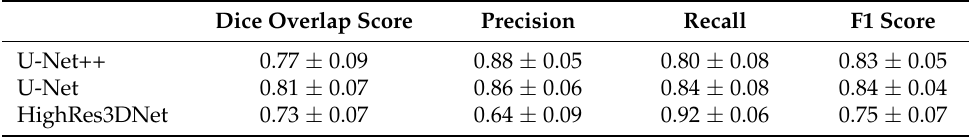
Figure 5. Comparison of the WMH reference and the predicted segmentation from each model (U-Net++, U-Net, and HighRes3DNet). Table 4. Average dice overlap score of WMH, along with precision, recall, and F1 score value.